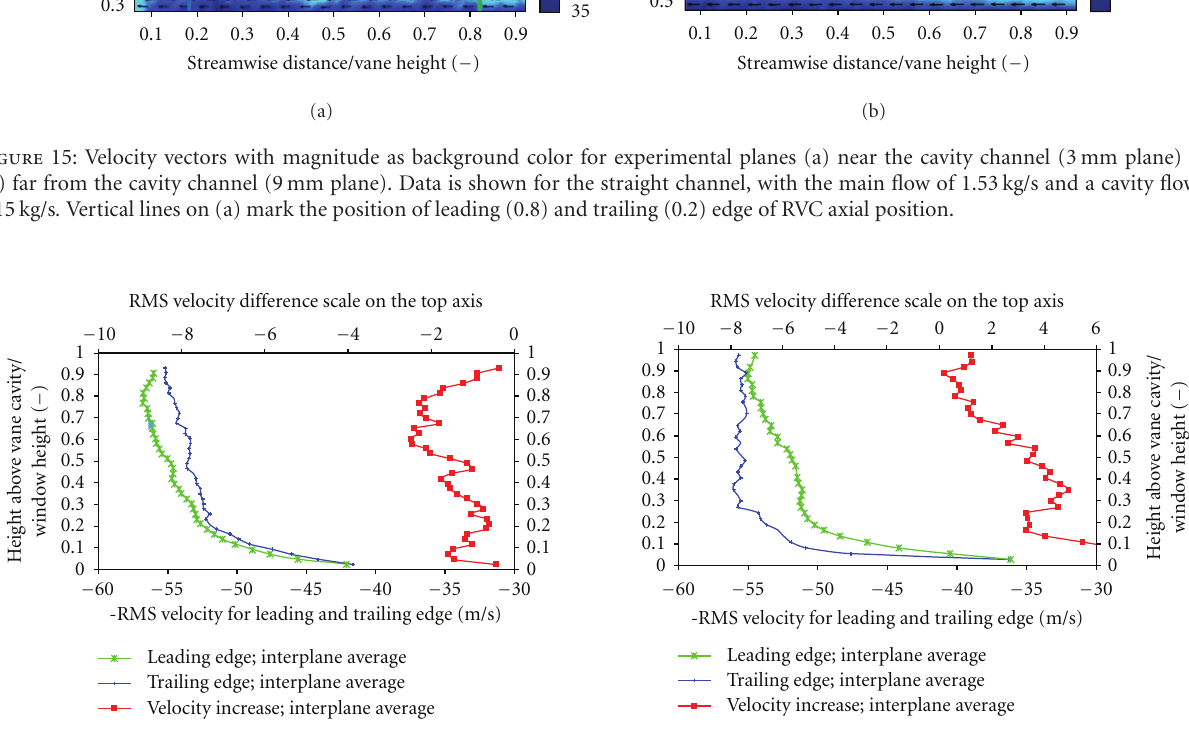
Figure 16: Velocity profile over RVC for straight configuration, 1.5kg/min main airflow.